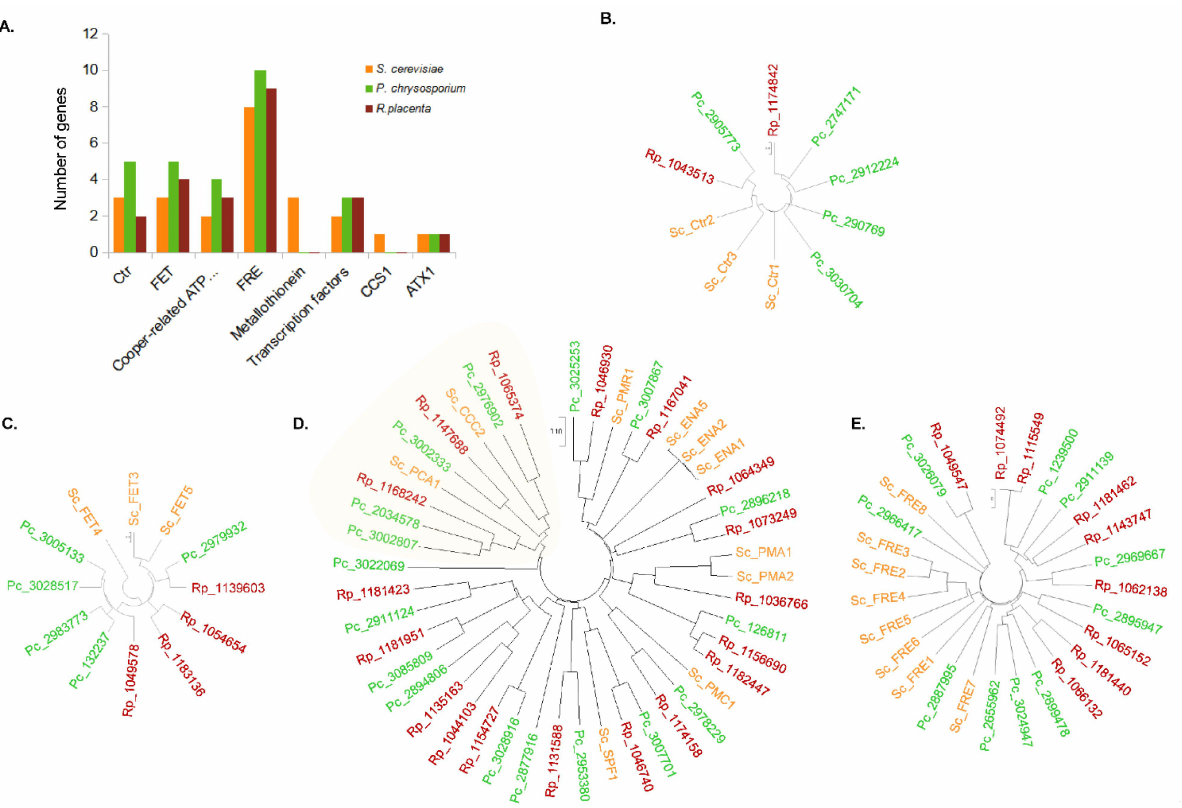
Figure 6. Comparative genomic analysis of copper-related genes in P. chrysosporium, R. placenta, and S. cerevisiae . ( A ) Number of genes coding for the well-known copper-related proteins in S. cerevisiae , related to copper transporters (Ctr, FET, ATPases and FRE), intracellular chelating proteins (Met- allothionein), transcription factors, the copper chaperone for superoxide dismutase CCS1, and the cytosolic copper metallochaperone ATX1. Phylogenetic relationship between S. cerevisiae (in orange), R. placenta (in red), and P. chrysosporium (in green) genes coding for Ctr ( B ), FET ( C ), P-ATPases ( D ), and FRE ( E )